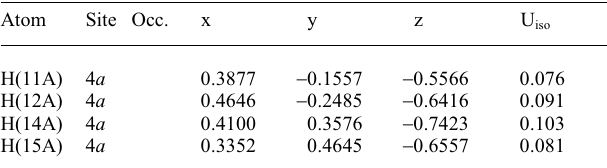
Table 3. Atomic coordinates and displacement parameters (in Å 2 )